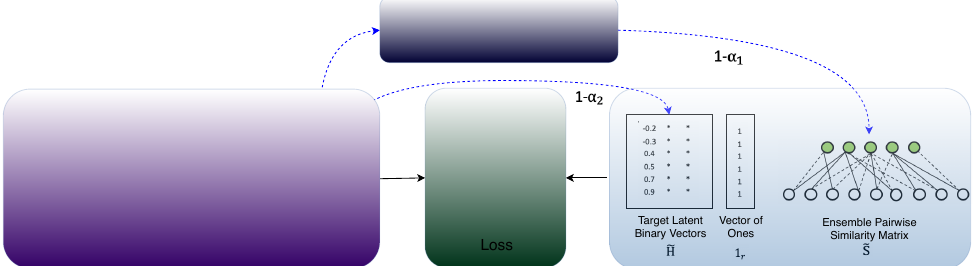
Figure 1. The framework of the proposed method, UDPH, which utilizes the VGG-16 model as our backbone network. MSE denotes the mean square error/loss, and WCE means the weighted cross-entropy loss. WCE utilizes the similarity obtained from the ensemble pairwise similarity matrix as the weight, MSE with γ 1 is to calculate the loss between absolute values of latent binary vectors and vectors of ones, and MSE with γ 2 is to calculate the loss between latent binary vectors and target latent binary vectors. f θ ( · ) represents a convolutional neural network and H denotes latent binary vectors. α 1 and α 2 are non-negative values to adjust the weight of S and H ,